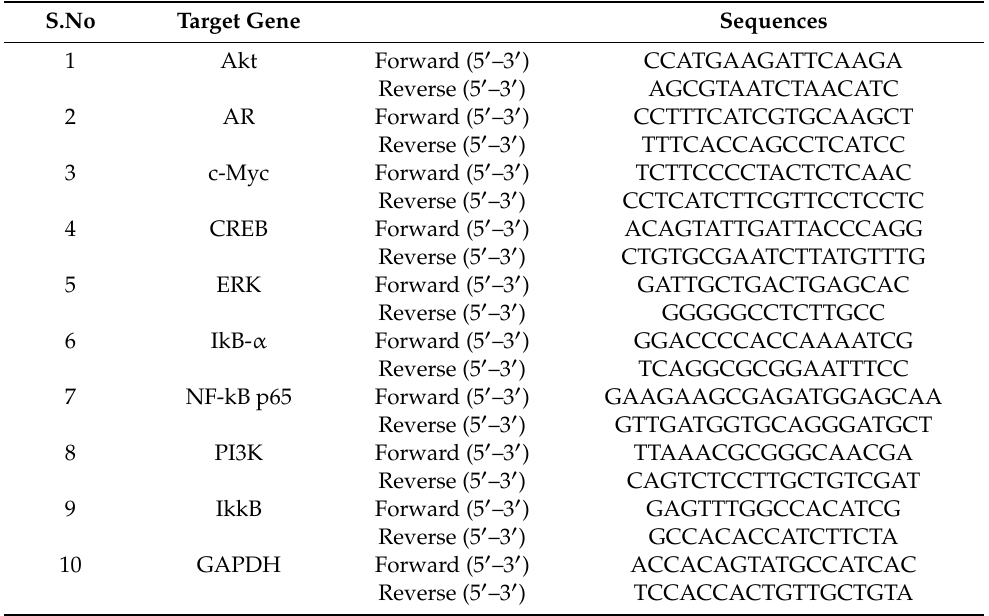
Table 1. Primer details used in this